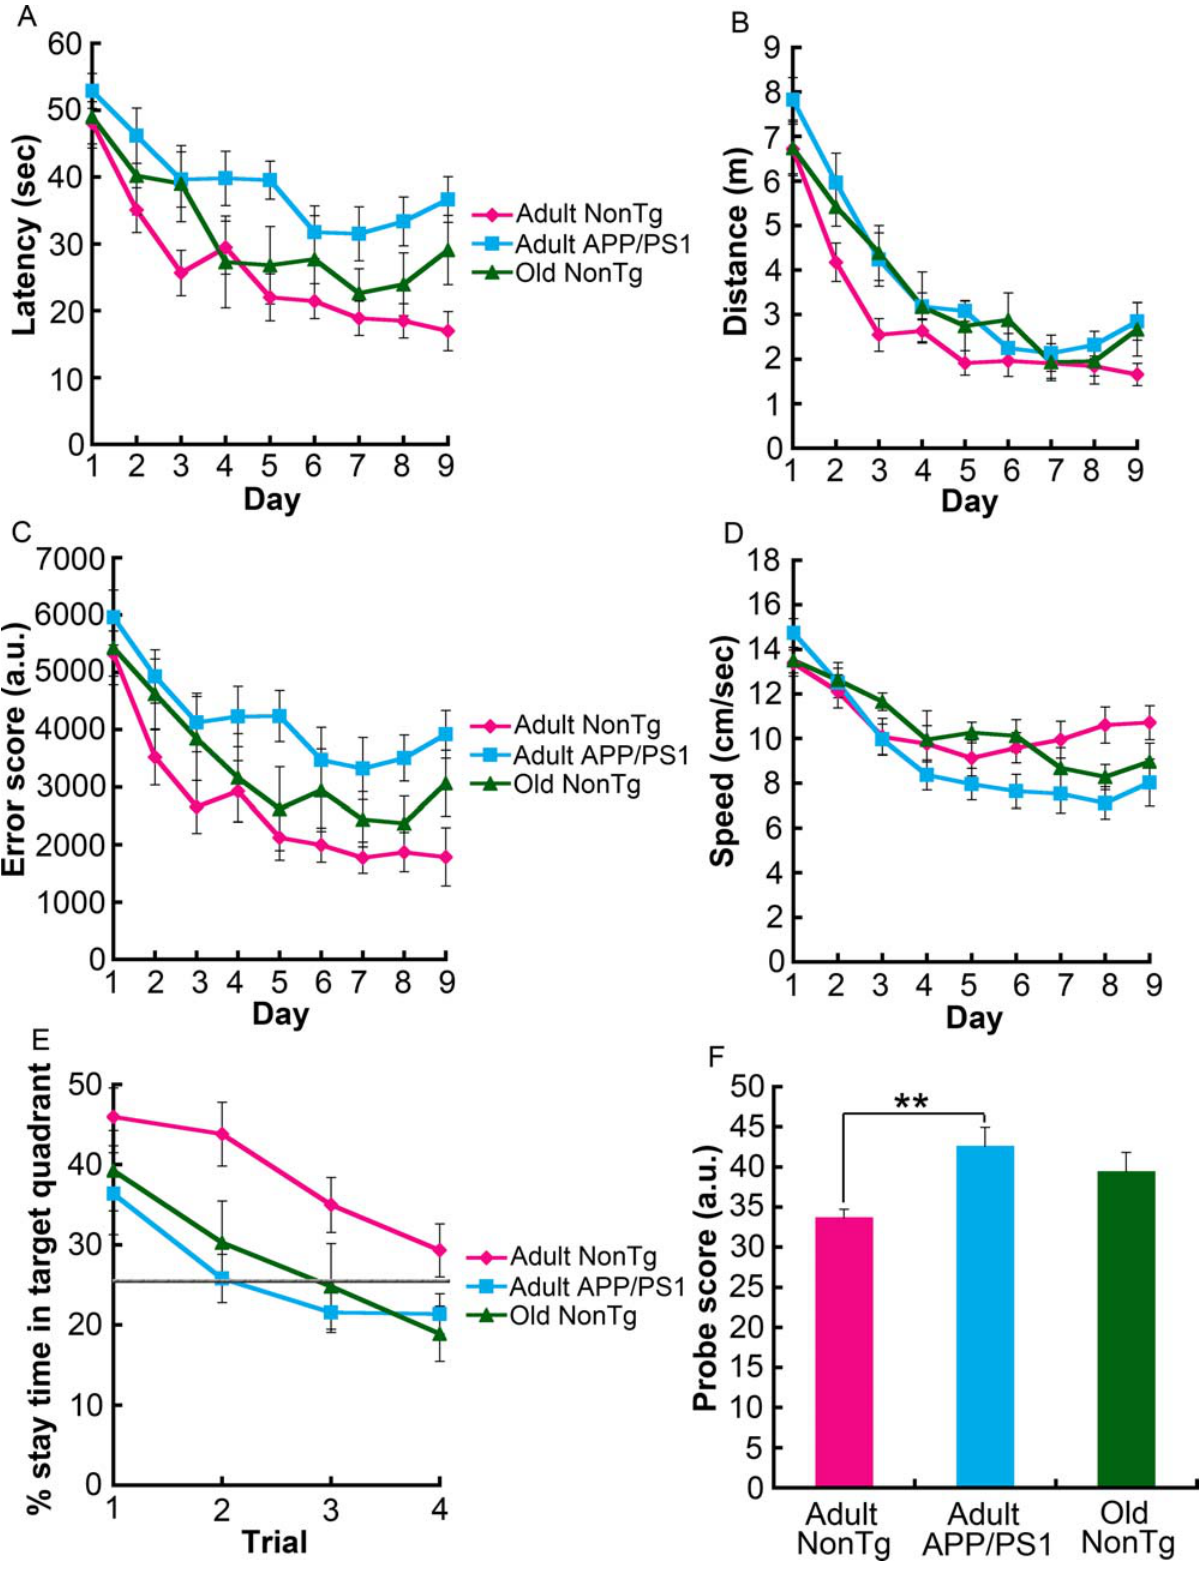
Figure 1. Memory decline in adult APP/PS1 mice in the MWM. (A) Adult APP/PS1 mice, but not old nonTg mice, took significantly longer than adult nonTg mice to reach the hidden platform over the 9-day task acquisition period (F[1,25]=17.95, p=0.0003, repeated measures two-way ANOVA). Differences between adult nonTg and adult APP/PS1 mice was also observed in both the distance or the path-length that the mouse swam (F[1,25]=11.69, p=0.0022) (B) and in the error score (F[1,25]=11.79, p=0.0021), which is defined in the Materials and Methods (C). (D) In terms of swimming speed, no statistical difference was detected among the three groups. (E) Four post-acquisition probe trials were run, and the average